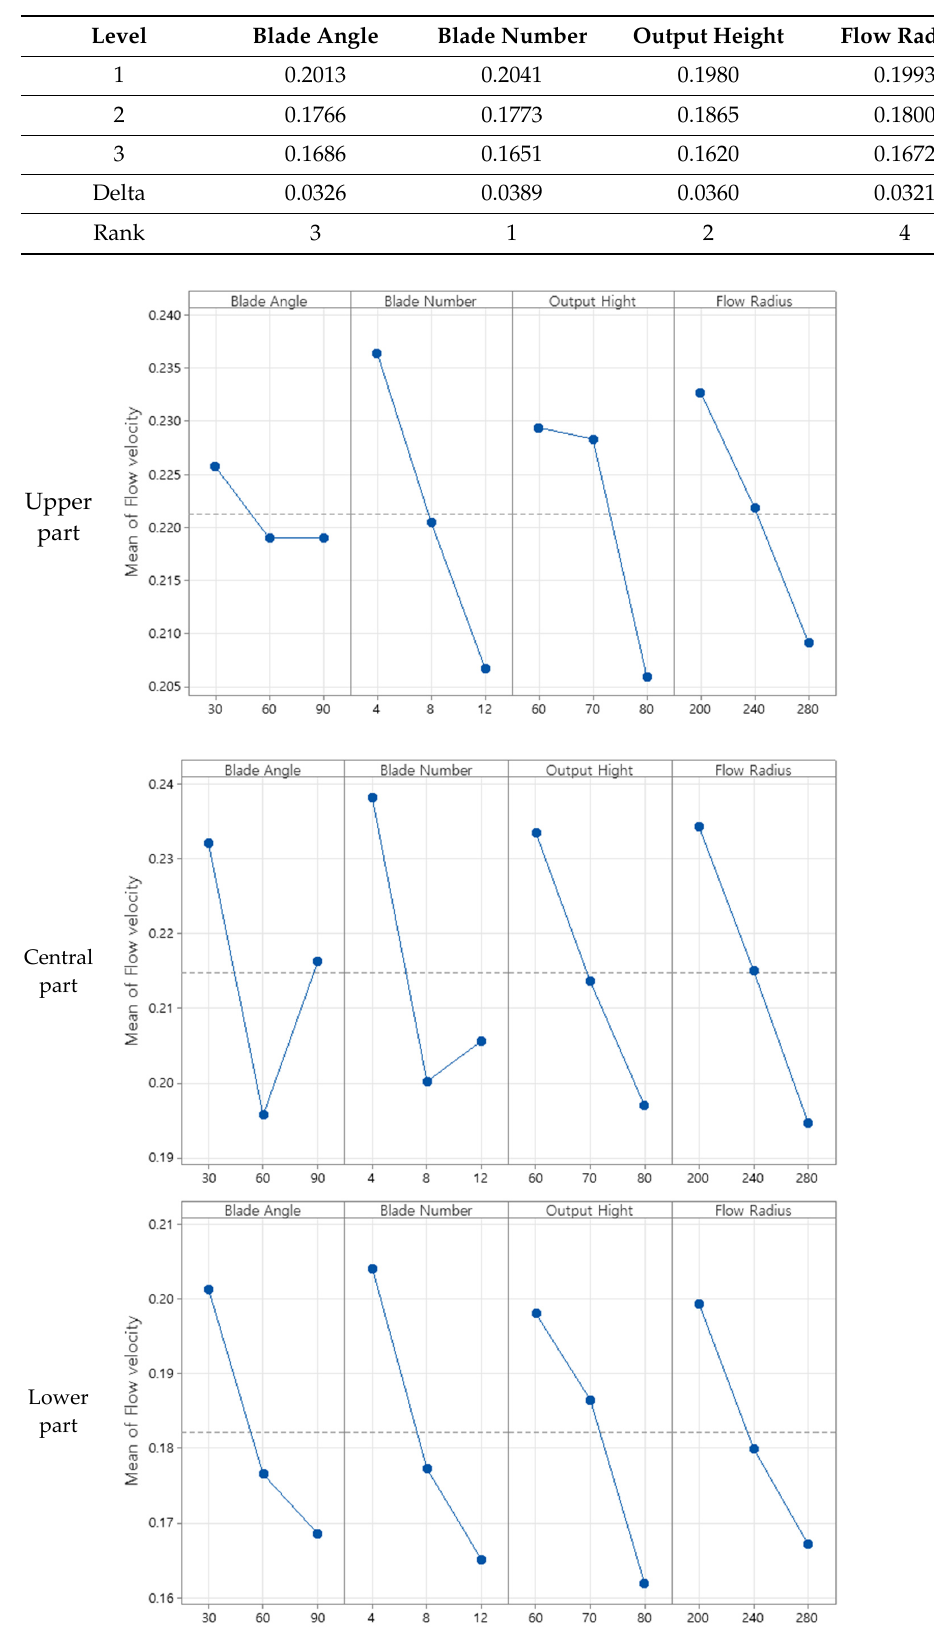
Figure 8. Main effects plot. Based on the average analysis results obtained through the design of experiment Taguchi method, the design variables with the largest contribution to the upper air flow rate were ordered as blade number > flow radius > output height > blade angle. Those with the largest contribution to the central air flow rate were ordered as flow radius > blade number > output height > blade angle, and those with the largest contribution to the lower air flow rate were ordered as blade number > output height > blade angle > flow radius. To maximize the effect of the air circulation device, the number of blades should